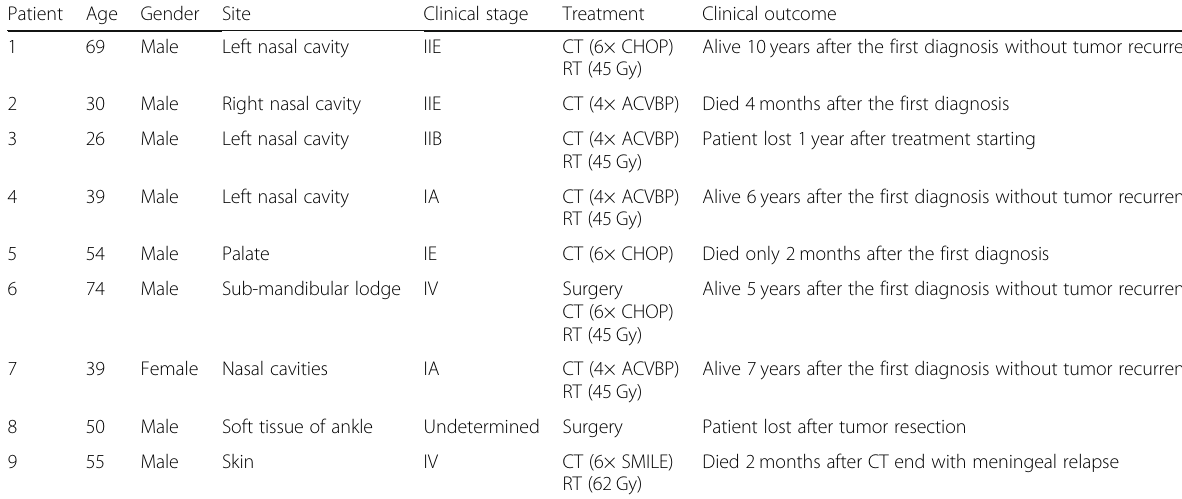
Table 2 Clinicopathological features of extranodal NK/T-cell lymphomas Patient Age Gender